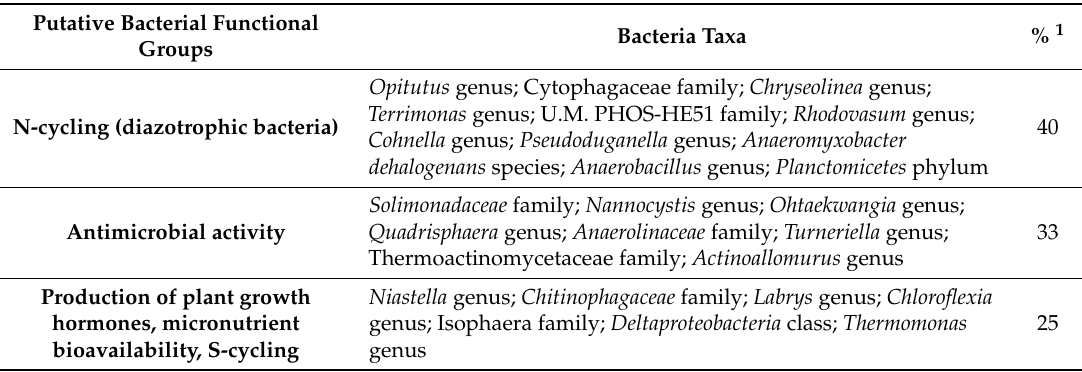
Table 4. The bacteria taxa showing a significant increase ( p -value ≤ 0.05) with Bio1 and/or Bio2 and their putative functions in the growth and health of maize